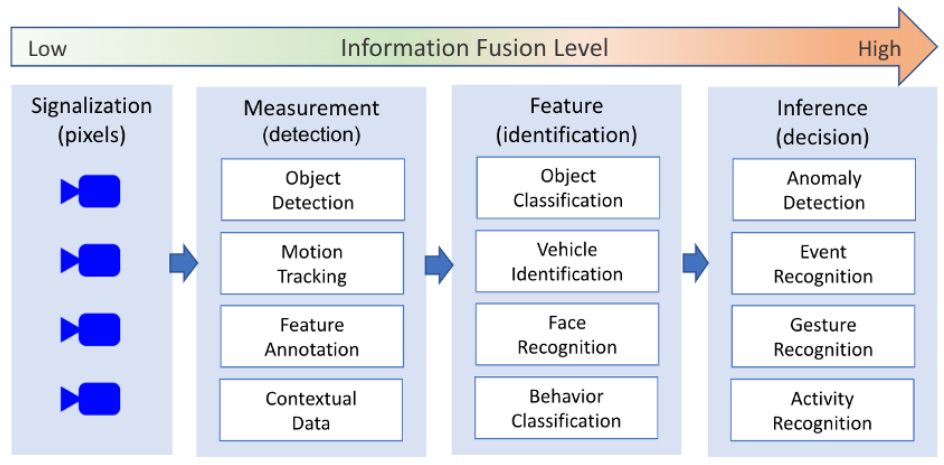
Figure 1. Dividing the processing tasks for event-based video